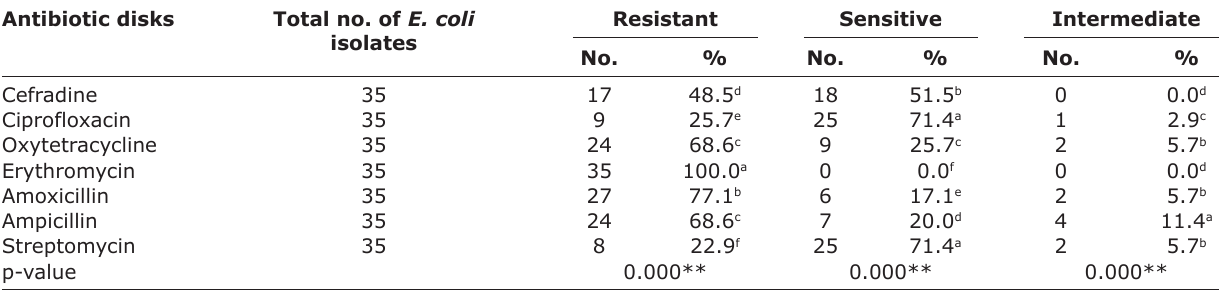
Table-11: Results of the antibiotic sensitivity test of E. coli isolated from human samples. Antibiotic disks